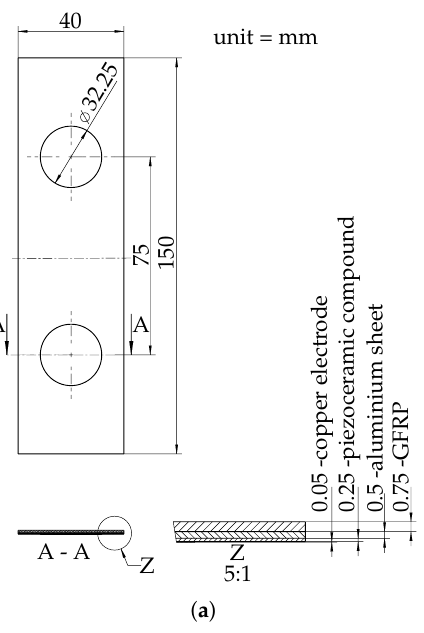
Figure 1. Prepared specimen ( a ) drawing; ( b ) front and back